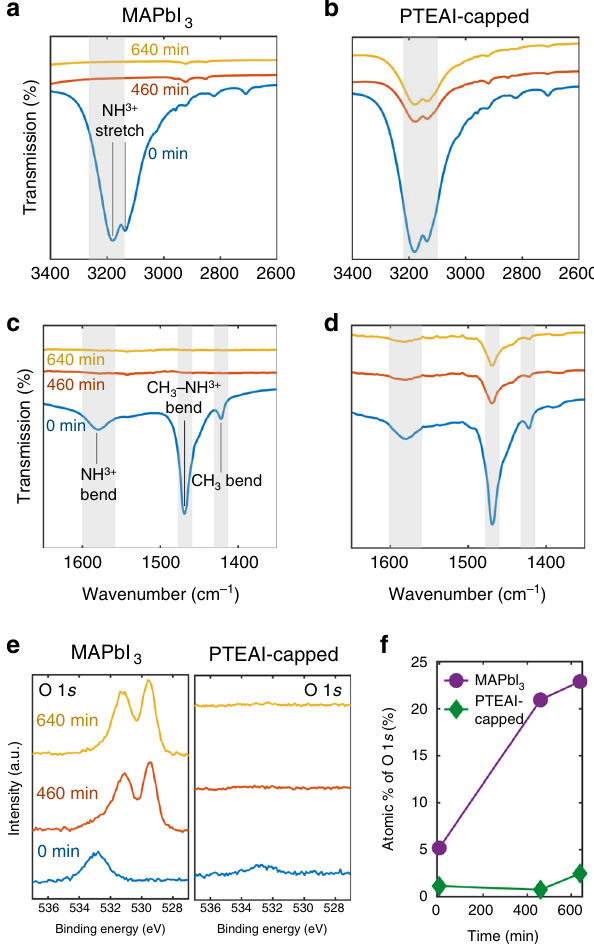
Fig. 5 Capping-layer surface chemistry characterization of optimum capping layer (PTEAI). Attenuated total re fl ection Fourier-transform infrared spectroscopy (ATR-FTIR) with ZnSe crystal of bare ( a , c ) and PTEAI-capped MAPbI 3 ( b , d ). e The O 1 s spectra obtained from x-ray photoelectron spectroscopy (XPS) of bare and PTEAI-capped MAPbI 3 , and f their corresponding atomic percentages. The purple circle and the green diamond represent the atomic percentages of O 1 s for bare and PTEAI- capped MAPbI 3 fi lm,